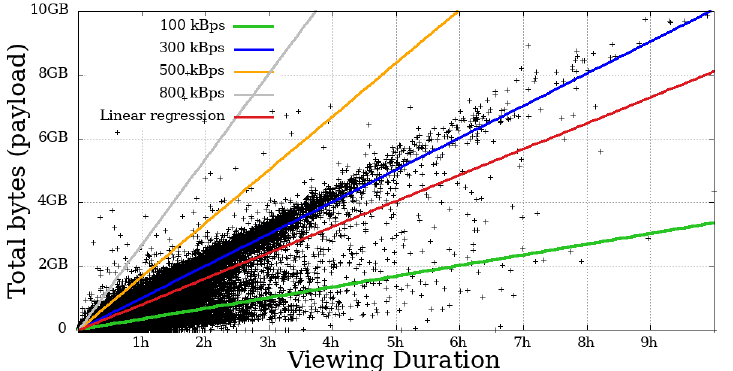
Figure 14. Bytes throughput per second of mobile users on the system in the broadcast Impeachment start session— Camara dos Deputados .